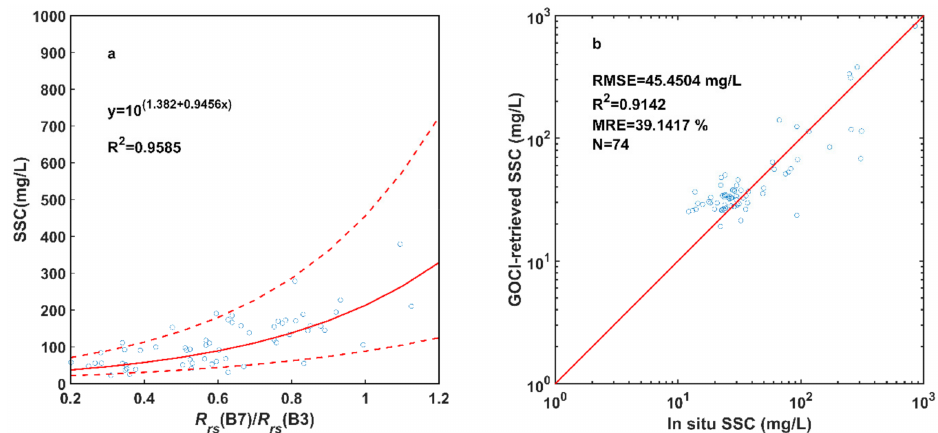
Figure 7. ( a ) The tuned empirical suspended sediment concentration (SSC) model using B7/B3. The red solid line is the fitting result, and the red dotted line represents the 95% confidence interval. ( b ) Scatter plots of comparisons between the GOCI-retrieved SSC and in situ observations measured in 2017. The red straight line represents the 1:1